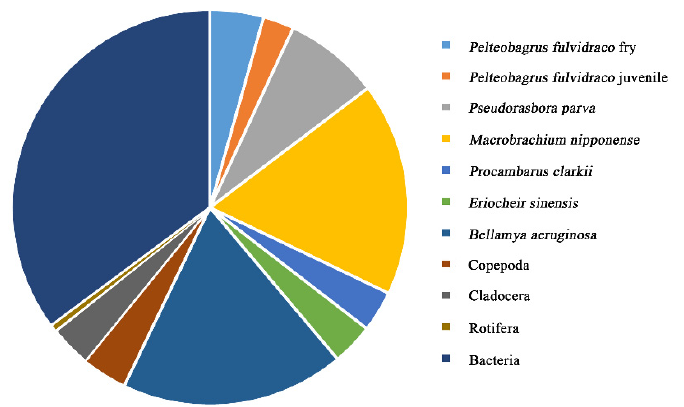
Figure 3. Proportion of energy throughput consumption.